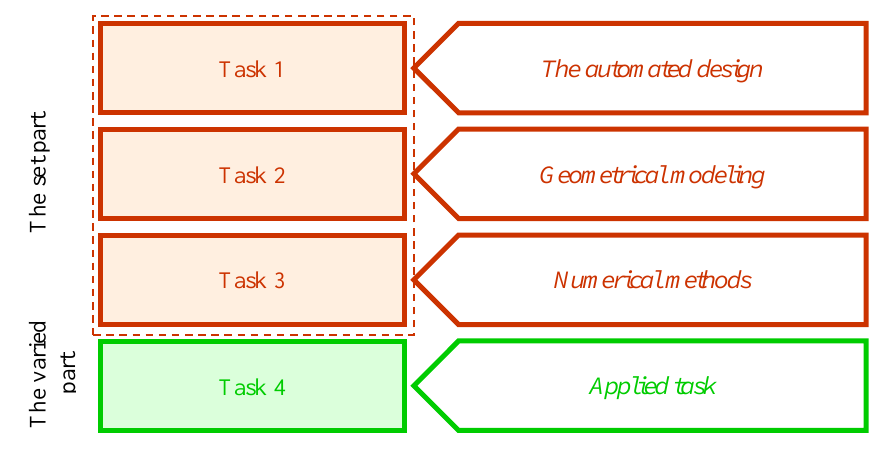
Fig. 4. Version of the project